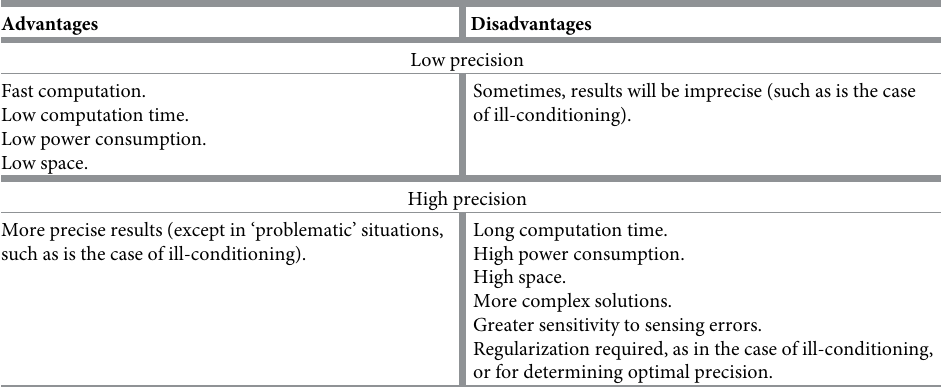
Table 11. Advantages and disadvantages of low and high precision.